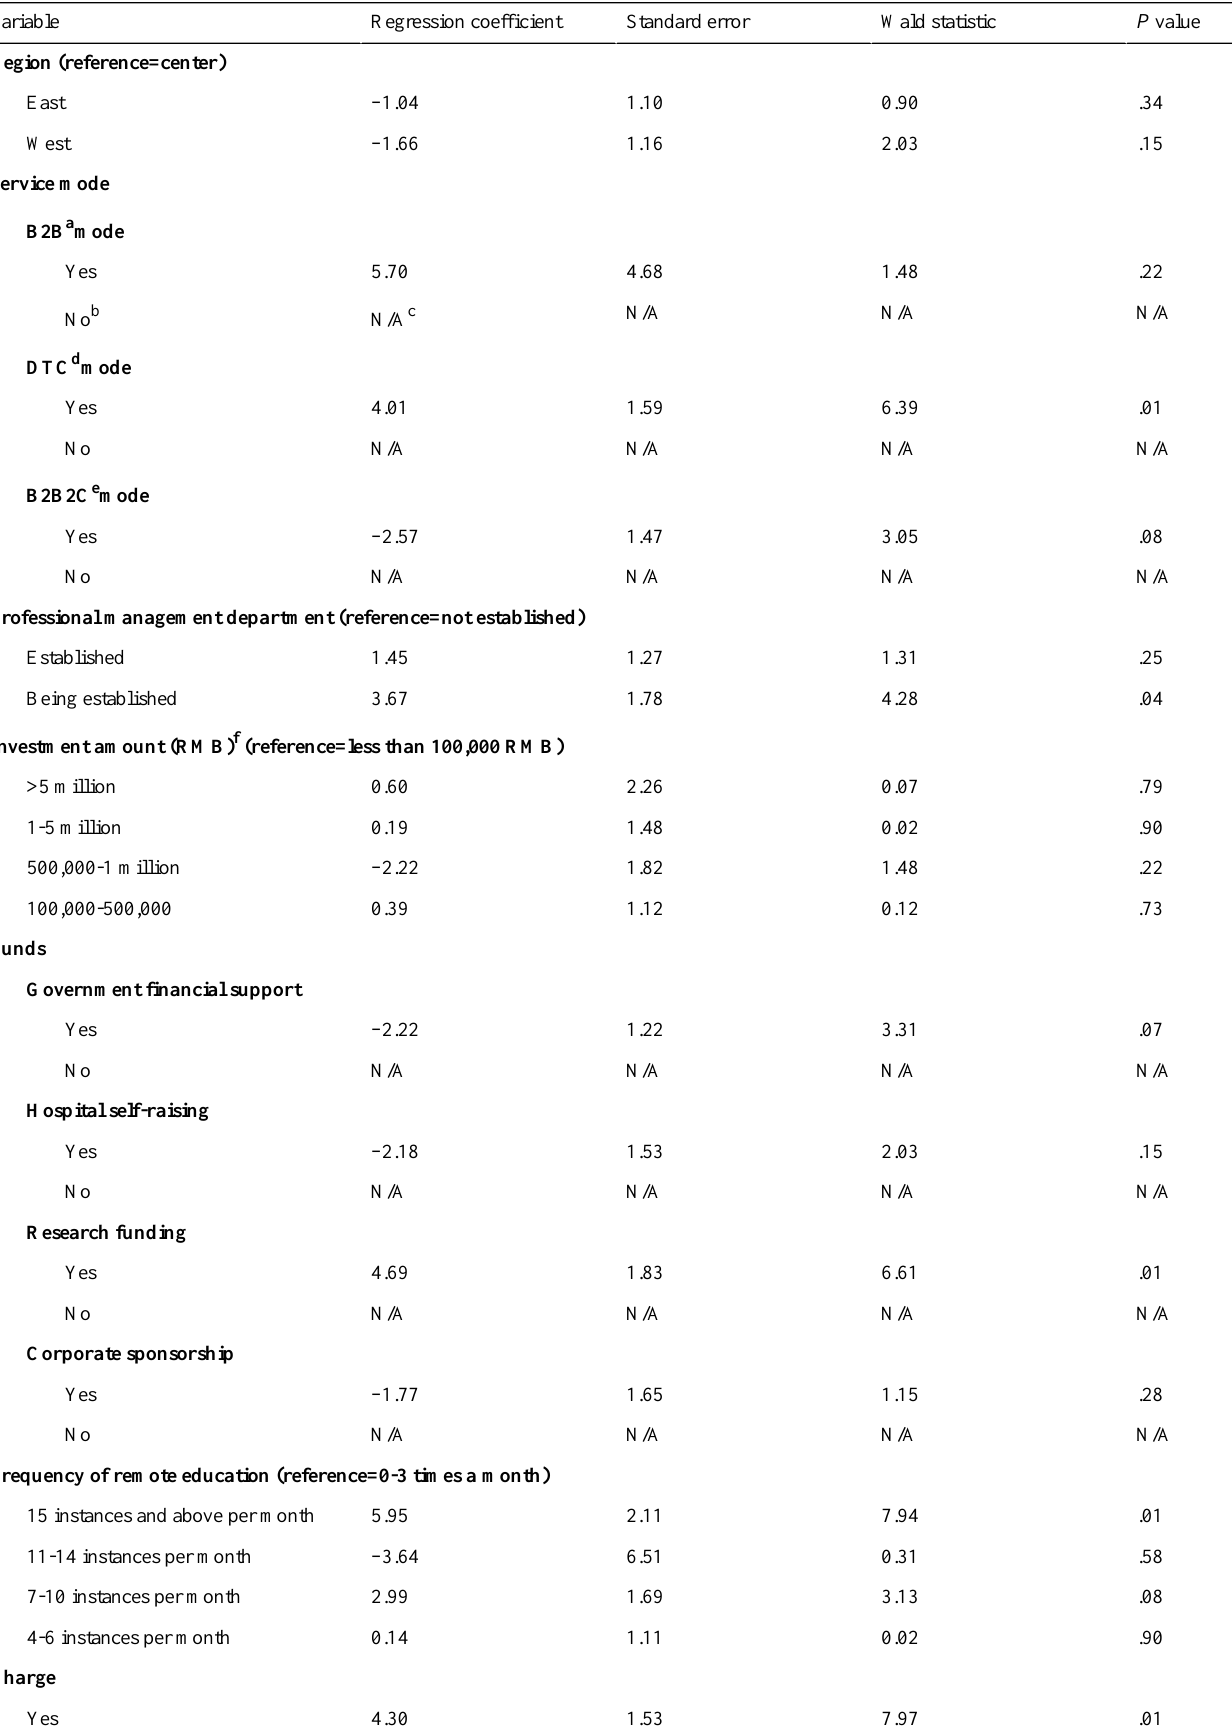
Table 7. Ordinal logistic regression results of the influencing factors of the remote education effect.